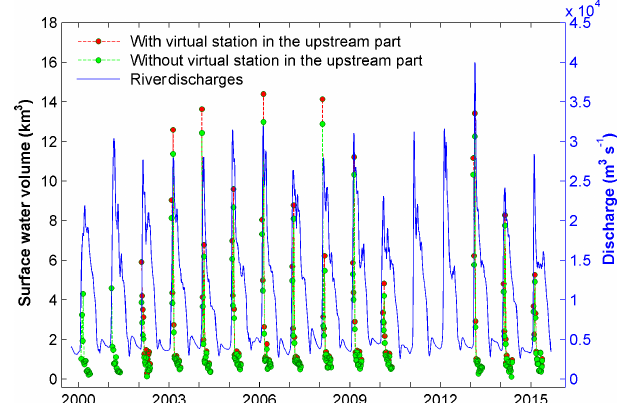
Figure 10. Surface water volume from 2000 to 2015, determined by combining inundated surfaces from MODIS with altimetry data; 167 red points correspond to surface water volume obtained with a virtual station located in the upstream part of the Delta, green points to surface water volume without a virtual station located in the up- stream part of the Delta. The Mackenzie River Delta discharges at 10LC014 gauge station appear in